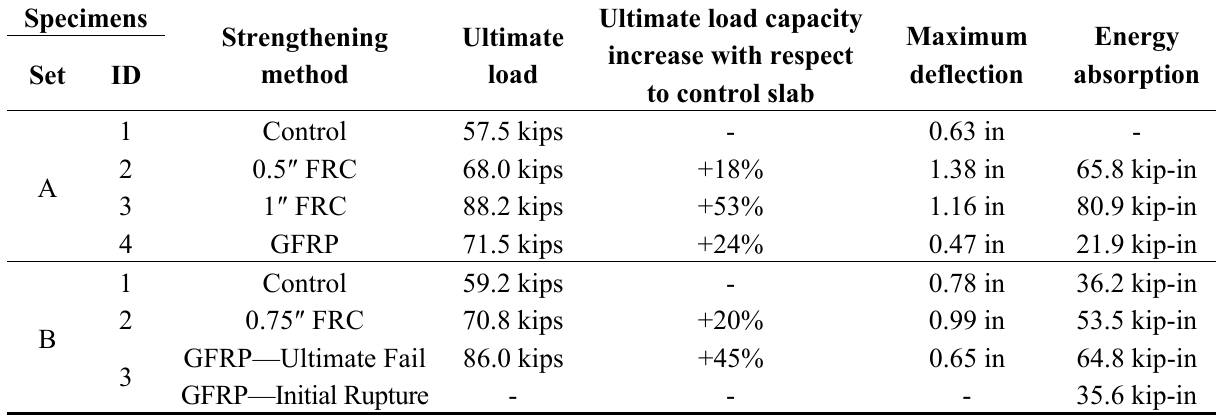
Table 5. Test mat Rix and results—FRC Project.